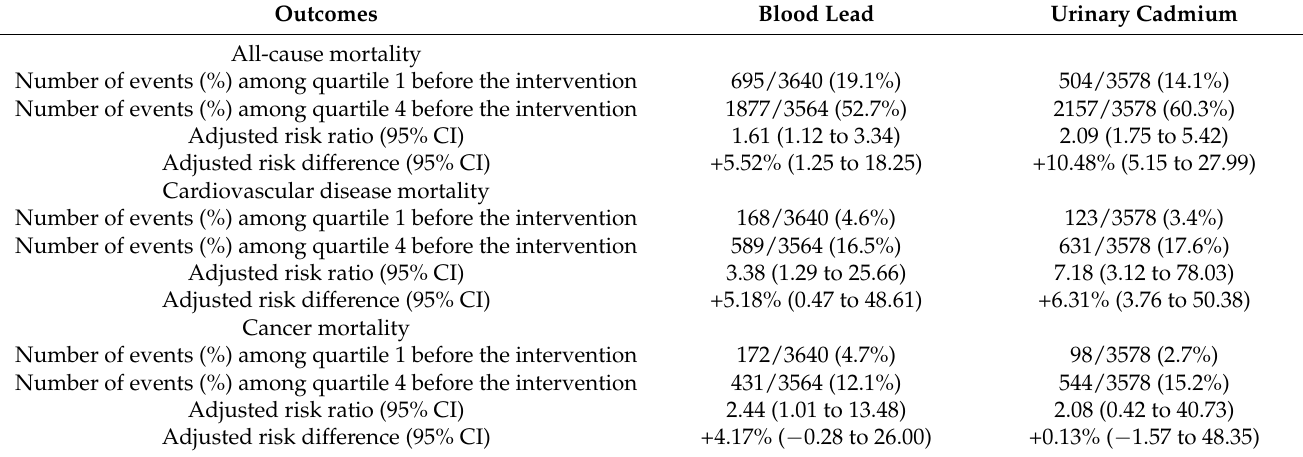
Table 3. Adjusted risk ratio and risk difference of all-cause and specific-cause of mortality for interventions setting participants in the fourth quartile compared to the first quartile for metal concentrations using parametric g-formula with pooled logistic regression models a